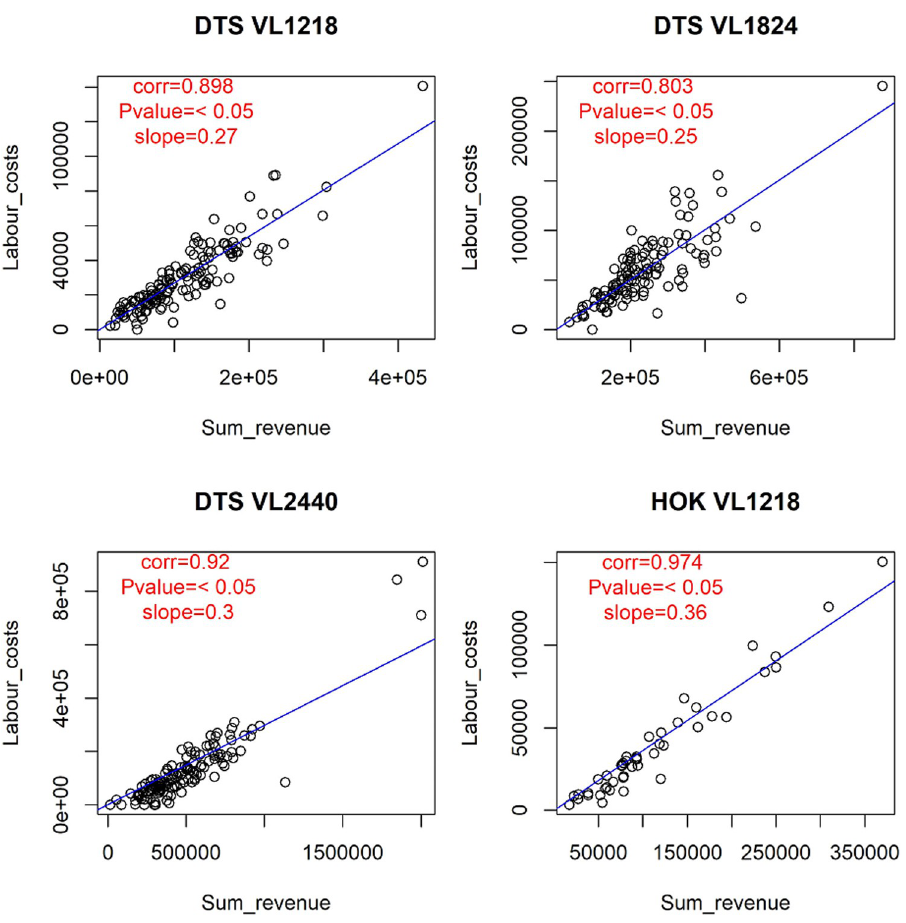
Fig 5. Linear correlations between labor costs and hours at sea for the analyzed fleet